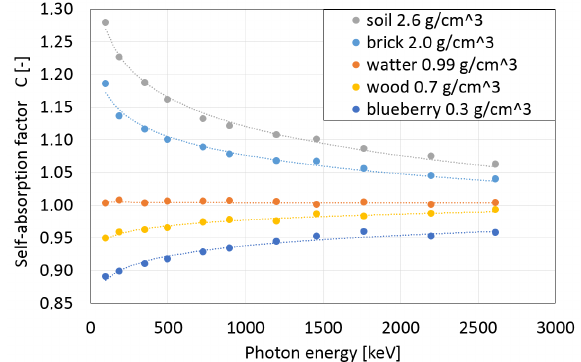
Figure 8. Correction factor for M280 geometry filled with